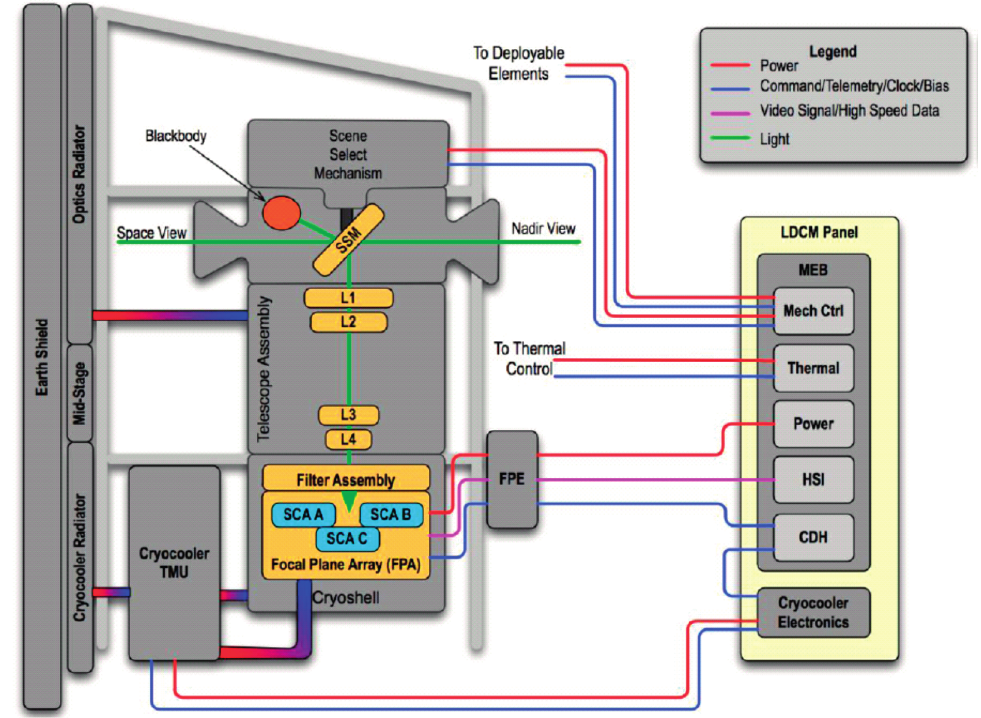
Figure 2. Block diagram showing the interfaces among the major parts of TIRS, including the light paths. SCA A, SCA B and SCA C , the three QWIP sensor chip assemblies (SCA); TMU, thermal-mechanical unit; HSI, high speed interface; L1–L4, the four lens elements; CDH, command and data handling. The other acronyms are defined in the text